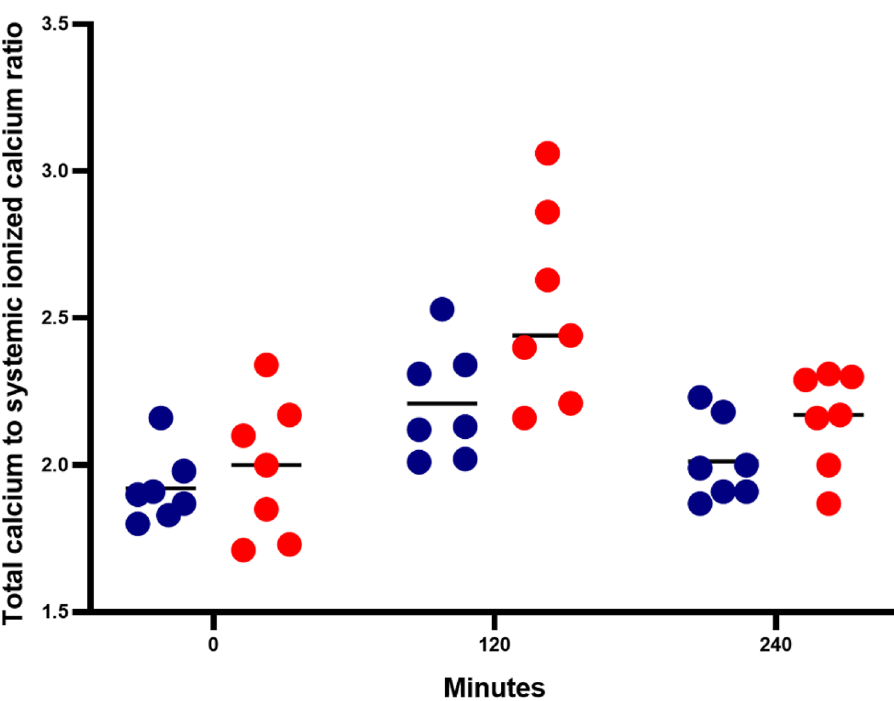
Figure 2. Comparison of the total calcium: systemic ionized calcium ratio between ALF (blue circles) and ACLF (red circles) at baseline, 120 min (end of 120-min citrate infusion), and 240 min (120-min after citrate infusion